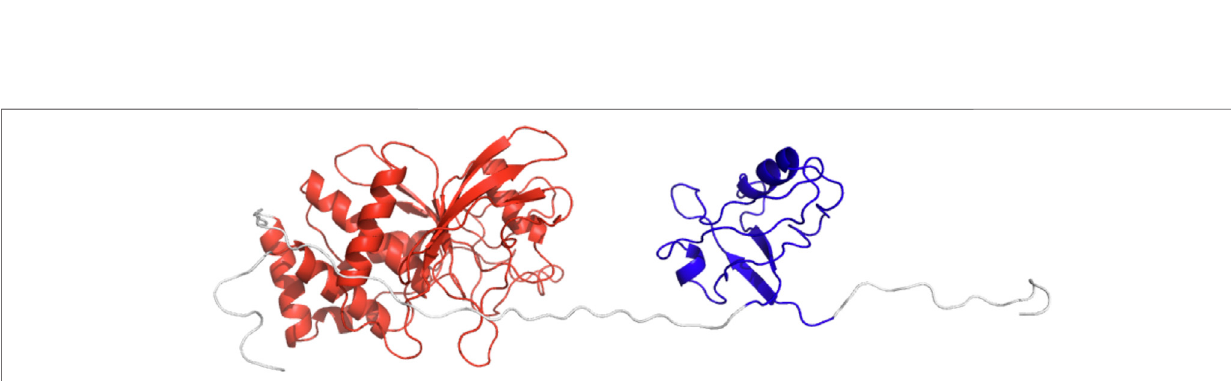
Frontiers in Molecular Biosciences |